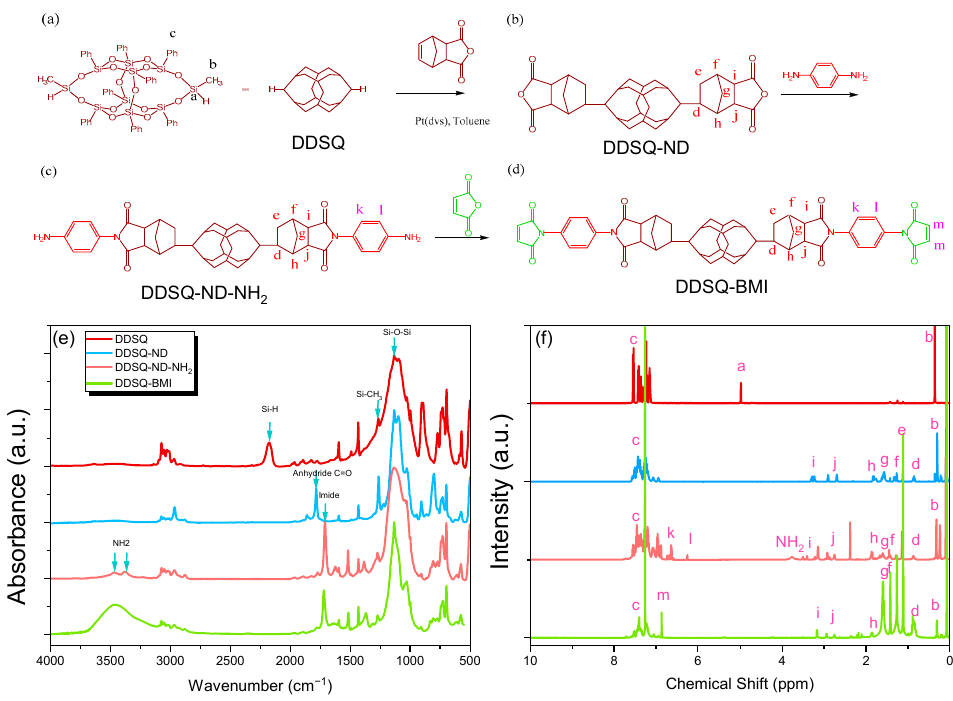
Figure 1. The synthesis of DDSQ-BMI ( d ) from ( a ) DDSQ, ( b ) DDSQ-ND, and ( c ) DDSQ-ND-NH 2 monomer; the corresponding ( e ) FTIR and ( f ) 1 H NMR spectra of each ( a – d ) compound.